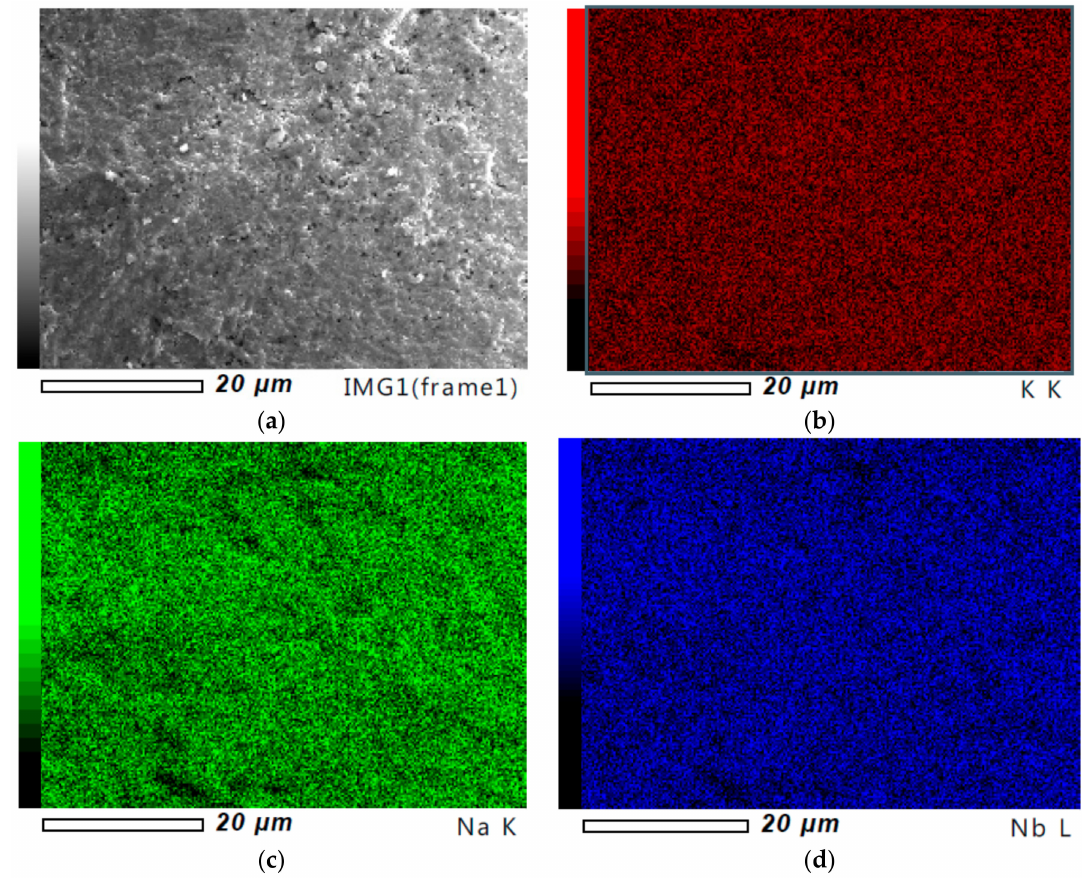
Figure 5. SEM micrographs of the ceramics obtained from the 75 h ( a ), element mapping of KNN ceramics across entire section–potasium( b ), sodium ( c ) and niobium ( d ).